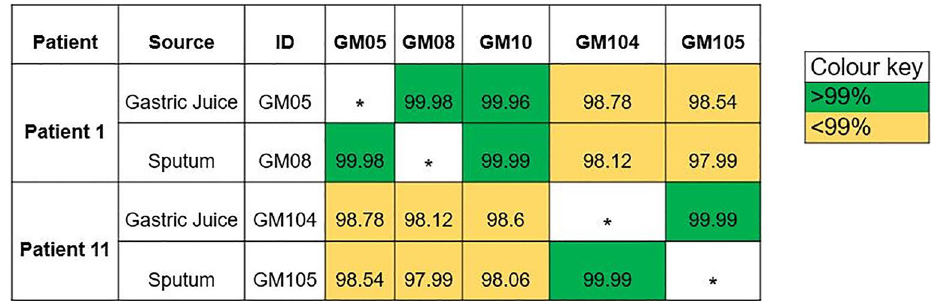
Figure 1. Average Nucleotide Identity pairwise comparisons of Pseudomonas aeruginosa isolate genomes from patient 1 and patient 11 lung and gastric juice samples. Comparisons coloured green have > 99% similarity and comparisons coloured yellow have < 99%